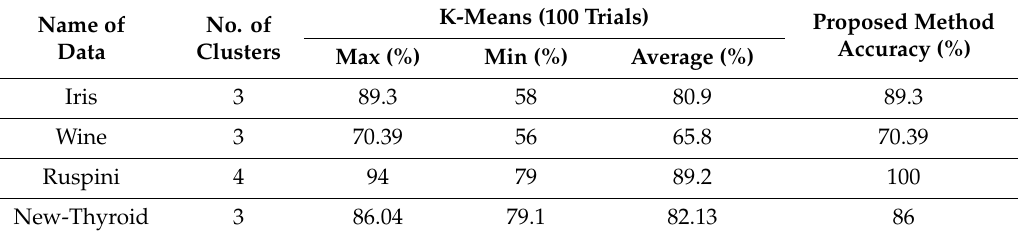
Table 1. Resulting accuracy of di ff erent